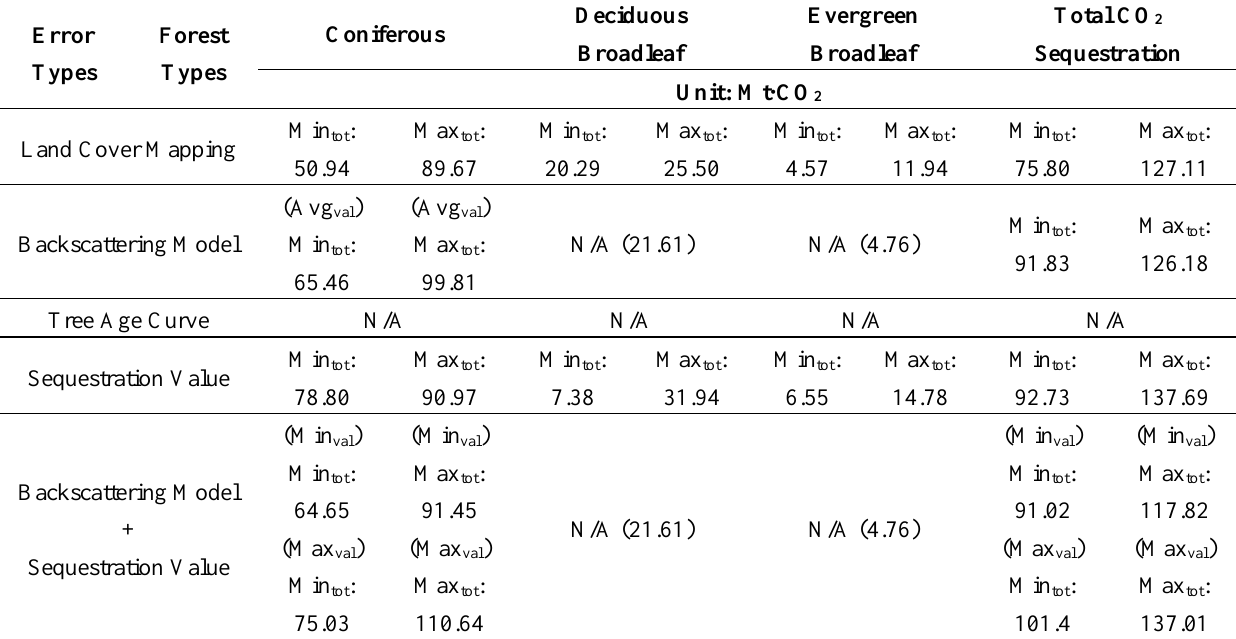
Table 7. Summary of total CO 2 sequestration estimated after considering each possible error